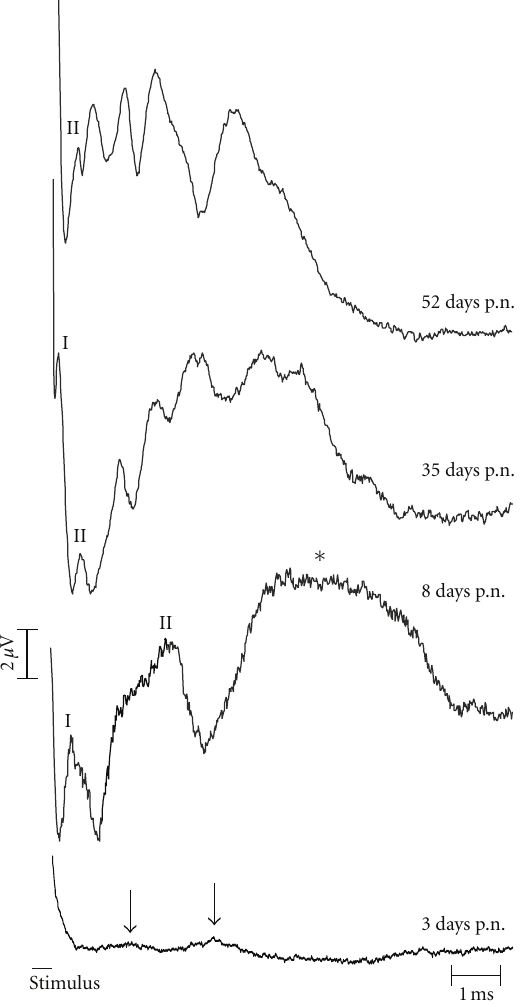
Figure 3: Development of E-ABRs in the first 52 days postnatally. All animals are from the white cat colony, but only after hearing onset (after day 10 p.n.) CDCs can be di ff erentiated from white cats with residual hearing. Stimulus: biphasic pulse, 200 μ s/phase at 10 dB above threshold. Stimulus duration is shown as a black bar, the artifact is removed form the recordings. At day 3p.n., even at this high stimulation intensity the amplitudes of the waves were very small and only two waves could be di ff erentiated from noise (marked by arrows). At day 8p.n., all waves were observed (at the high intensity shown, waves III–V fused into a single large wave marked by the